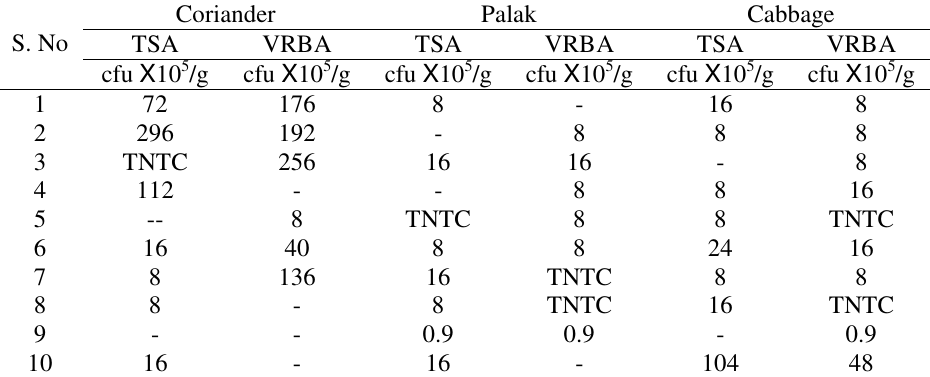
Table 6. Bacterial pathogens in random samples of green leafy vegetables Coriander